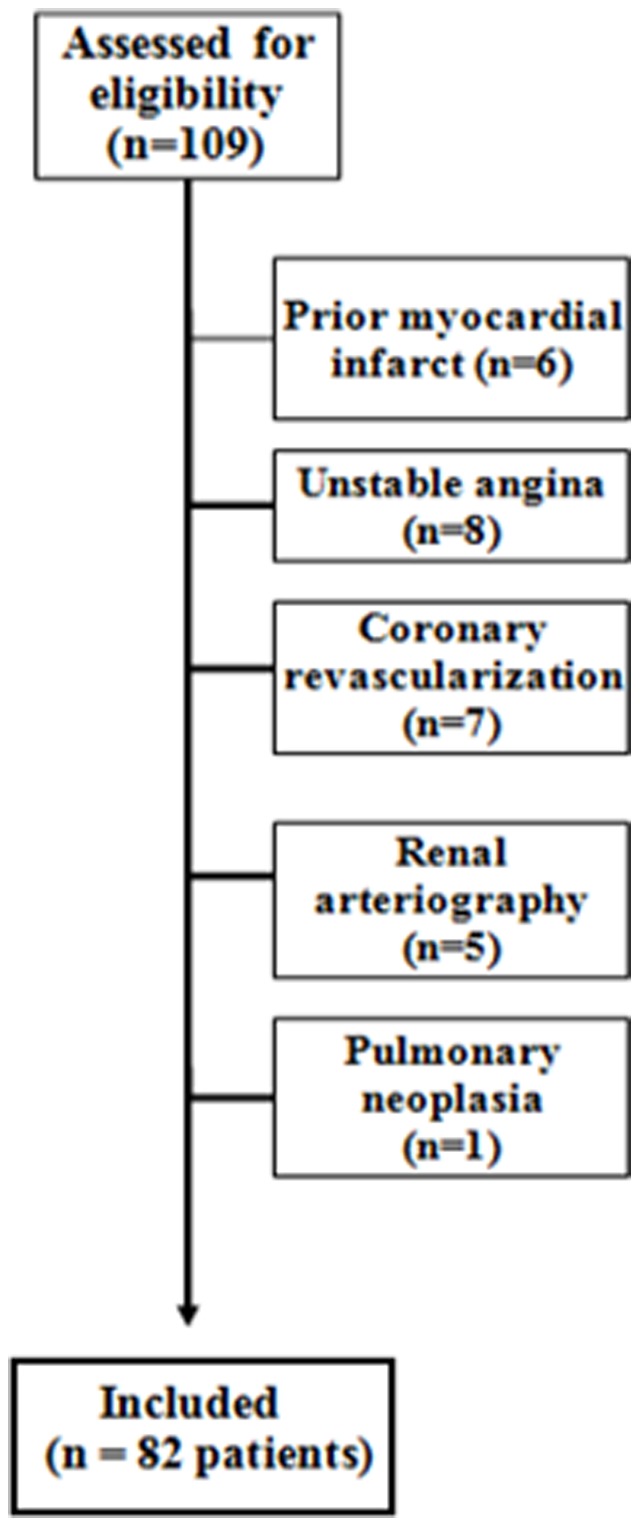
Patient selection flowchart.